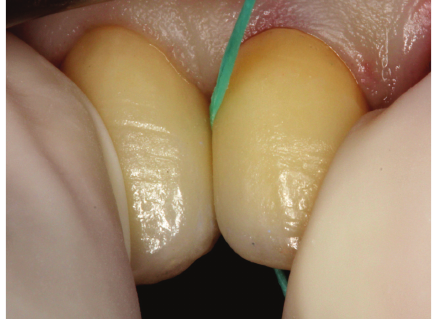
Figure 9: Porcelain laminate veneer.